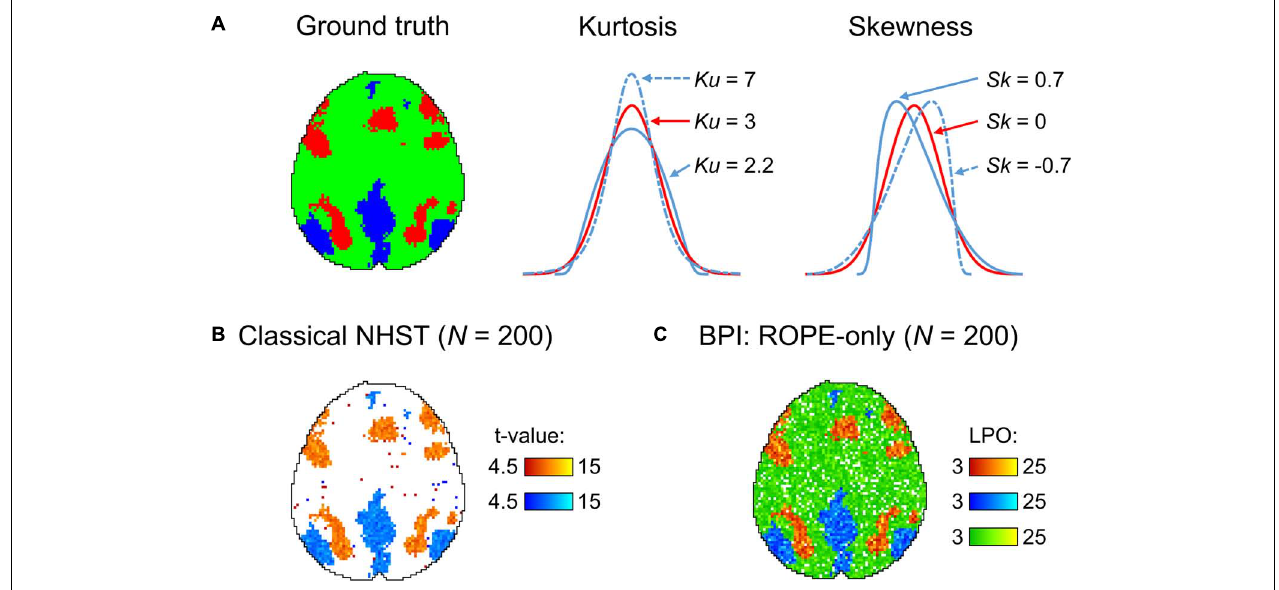
FIGURE 14 | Simulations overview. (A) Ground truth axial slice z = 36 mm (MNI152 standard space). ‘Activated’ and ‘deactivated’ voxels are marked in red and blue colors, respectfully. ‘Trivial’ voxels that should be classified as ‘not activated’ (practically equivalent to the null value) are marked in green. Data were drawn from the normal ( Ku = 3, Sk = 0, the red line) and non-normal distributions. (B) Classical NHST results for N = 200 images, moderate effect and medium noise ( θ = 0.2%, SD = 0.3%), obtained using voxel-wise FWE correction ( α = 0.05). (C) BPI results for N = 200 images, moderate effect and medium noise ( θ = 0.2%, SD = 0.3%), obtained using the ‘ROPE-only’ decision rule, P thr = 95% ( LPO > 3) and γ = 1 prior SD θ